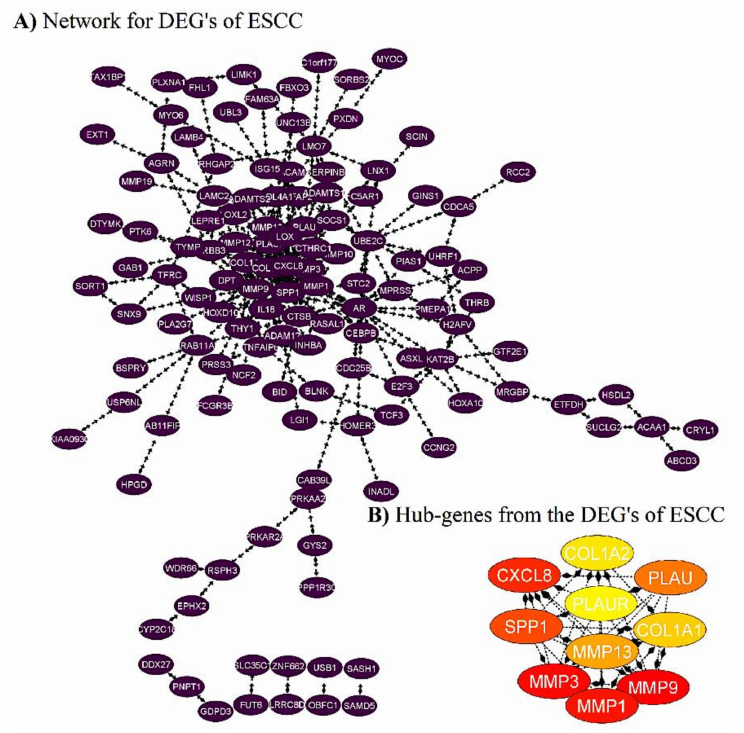
Figure 2. Visualization of the top 250 genes interaction as protein–protein interaction network and the HGsT10 genes, ( A ) PPI network of the genes interacted with two co-expression modules nodes and edges. Edges represent the HGsT10 genes’ interactions. Edges indicate interaction associations between nodes, ( B ) The predicted HGsT10 gene using MCC algorithm. Genes with a higher MCC sore are shown by red nodes, whereas yellow nodes represent genes with a minimal MCC